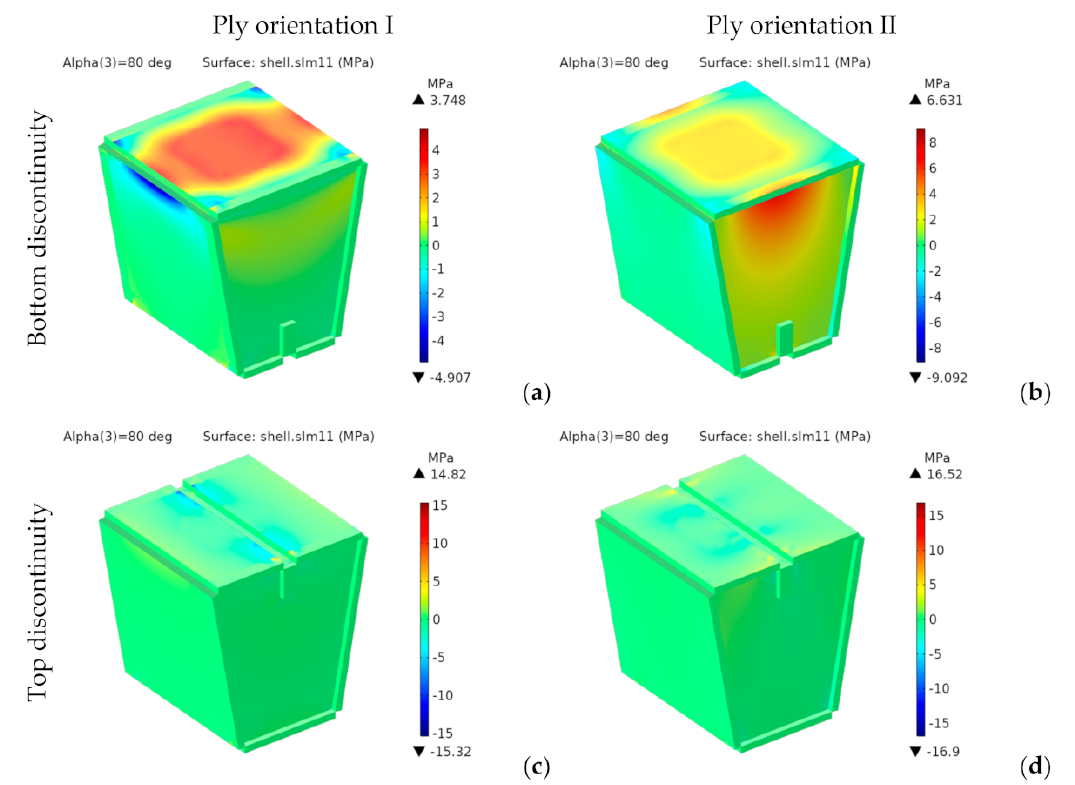
Figure 19. 1st design. Stress σ xx [MPa] for bottom ( a , b ) and top ( c , d ) discontinuity. For the designs with bottom discontinuity, σ xx and σ yy are distributed mainly on the seating surface. For orientation I, σ yy is also transmitted to the front and rear panels. On the contrary, for orientation II, σ xx and σ yy are transmitted to the side